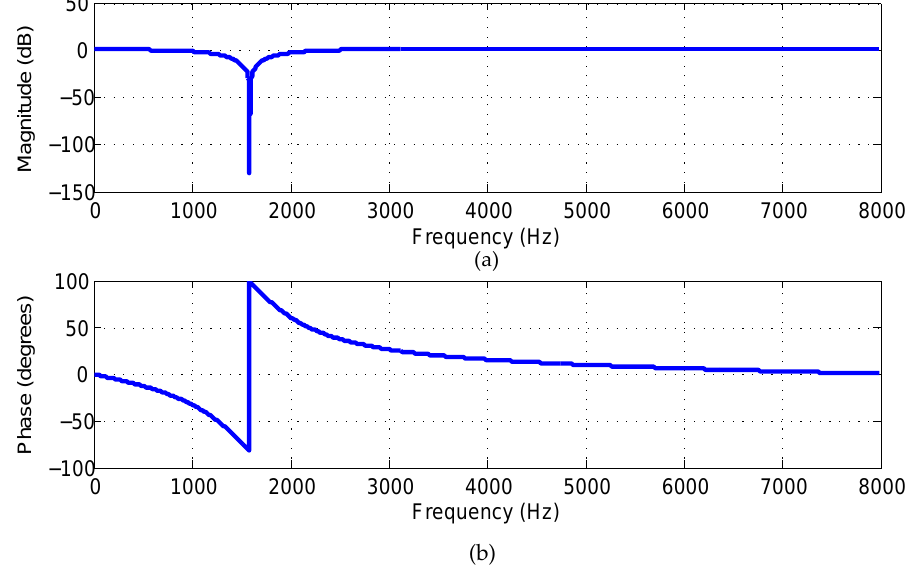
Figure 7. Conventional IIR notch filter frequency response: ( a ) The attenuation curve; ( b ) The phase-curve.